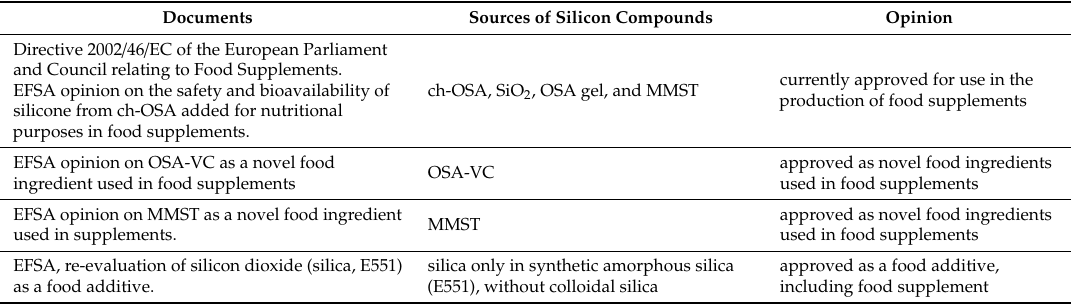
Table 3. Opinion on the safety and bioavailability of silicon of mineral origin approved for use in